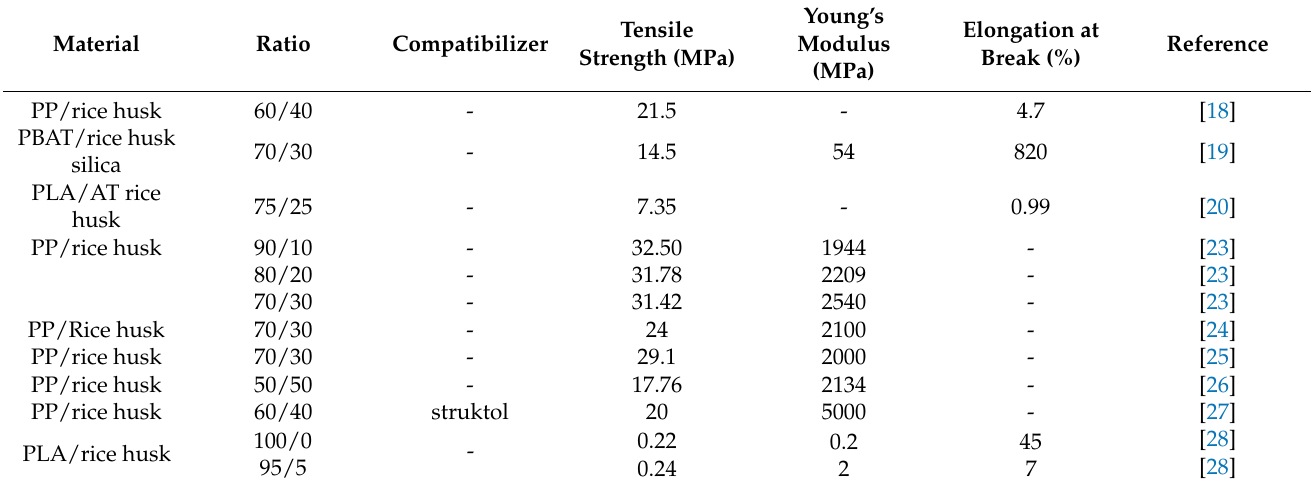
Table 1. The summary of biodegradable polymer/rice husk composites with their respective composition, plasticizer, and mechanical